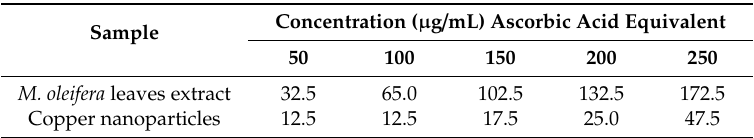
Table 4. Total antioxidant capacity (TAC) using phosphomolybdate assay.